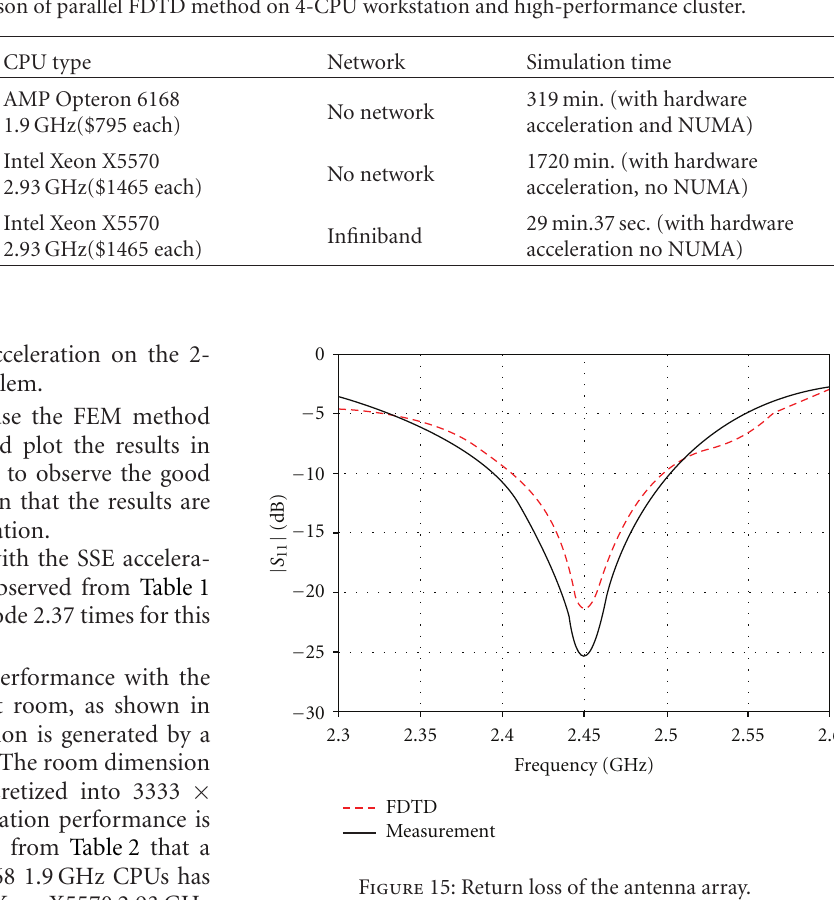
Figure 15: Return loss of the antenna